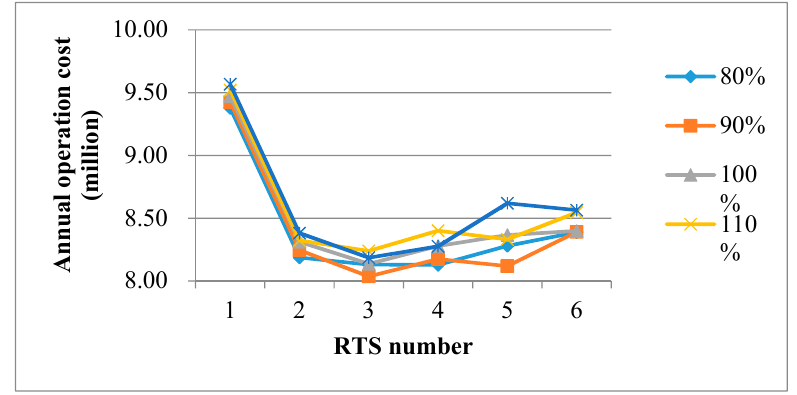
Figure 7. Sensitivity analysis of the unit variable cost in the RTS (refuse transfer stations).